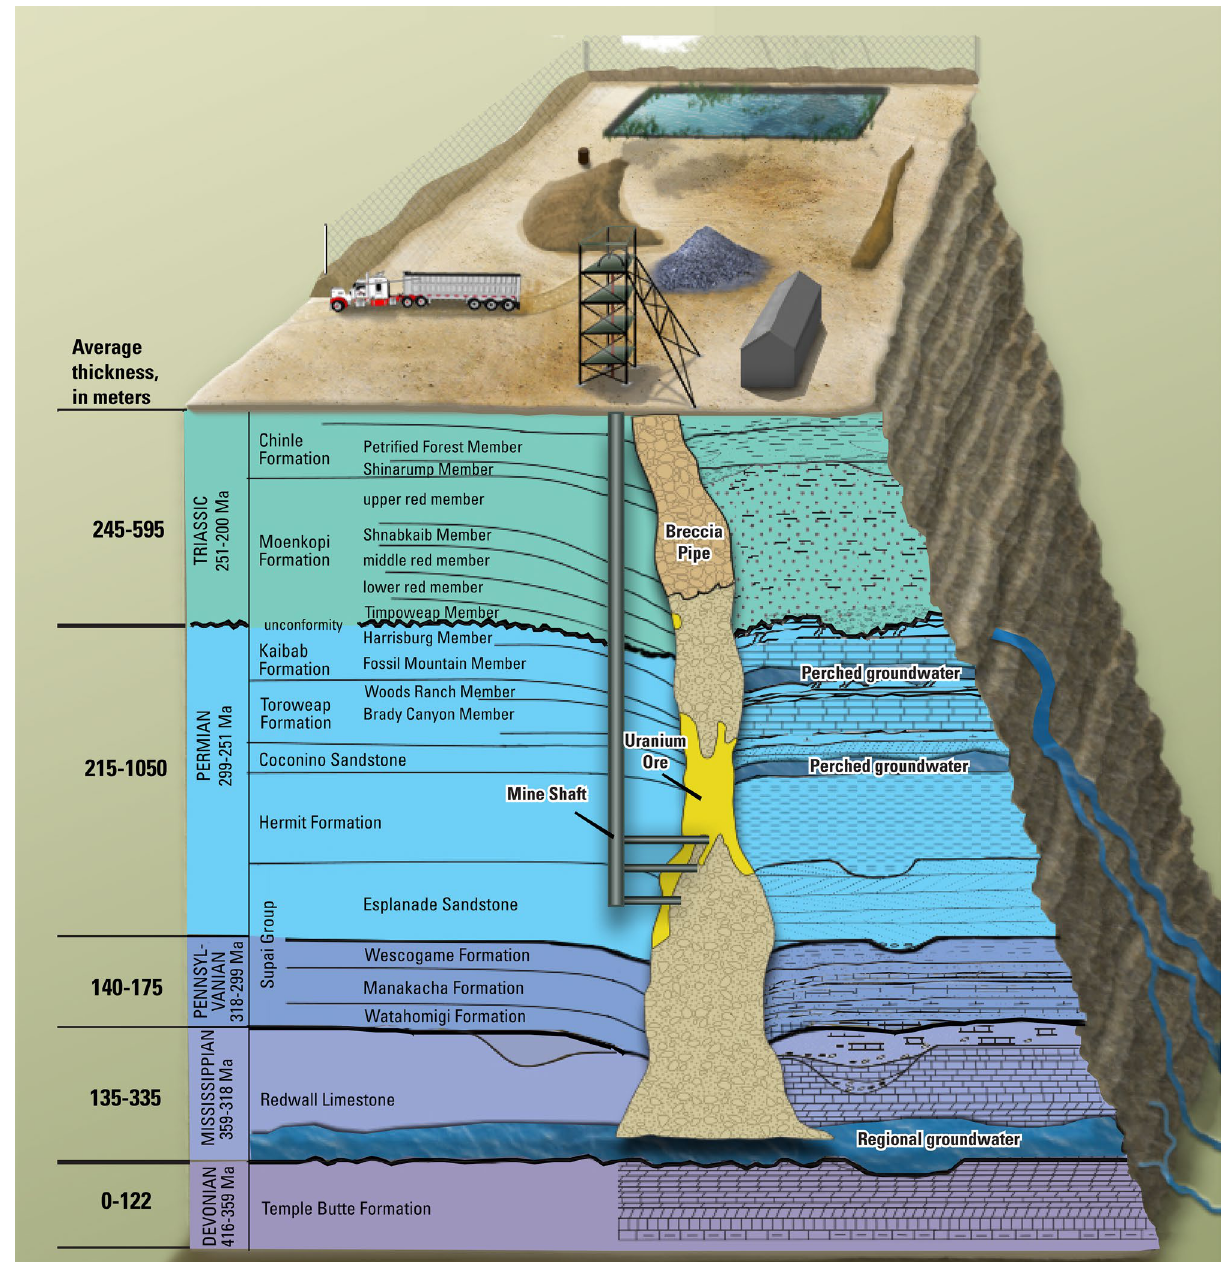
Figure 2. Schematic of lithology in the Grand Canyon area related to breccia pipe uranium mining. Adapted from U.S. Geological Survey 27